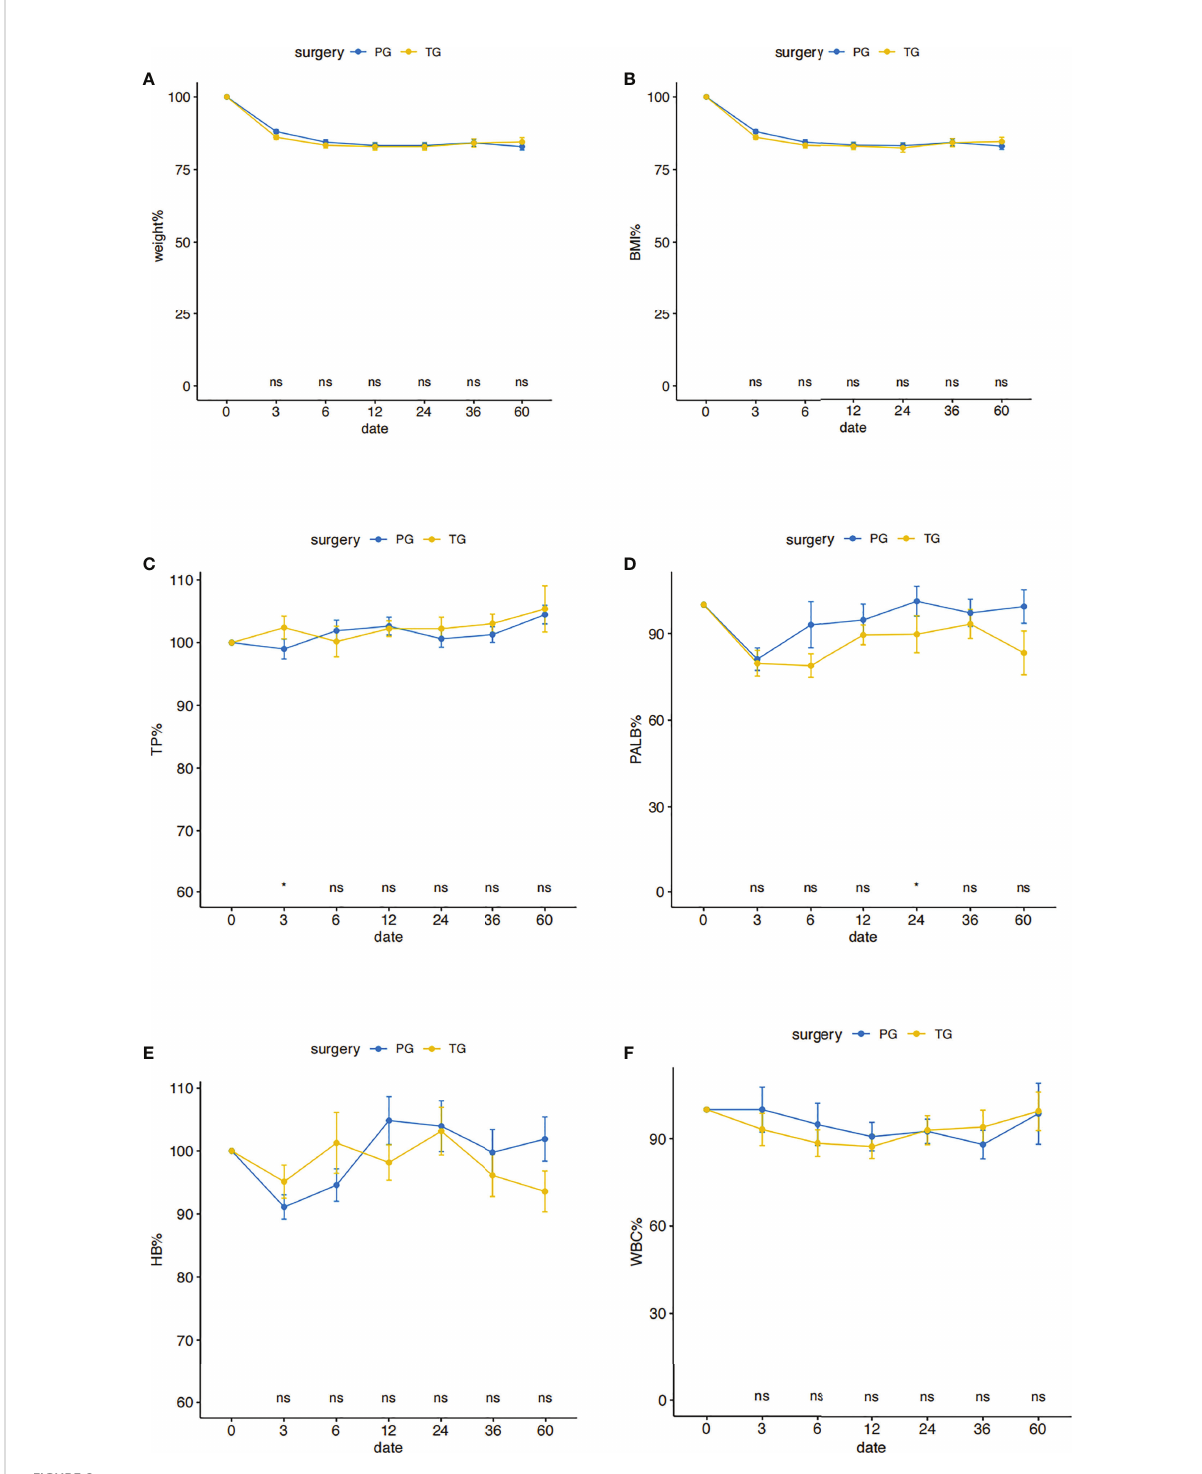
FIGURE 2 Postoperative nutritional status in the PG and the TG groups before PSM. Comparison of nutritional outcomes, Weight (A) , BMI (B) , TP (C) , PALB (D) , HB (E) , WBC (F) between PG and TG groups (TP: total protein, PALB: prealbumin, HB: hemoglobin, WBC: total leukocytes levels). All postoperative data are represented as a percentage of preoperative data. * p <0.05: signi fi cance level. PG blue line, TG yellow